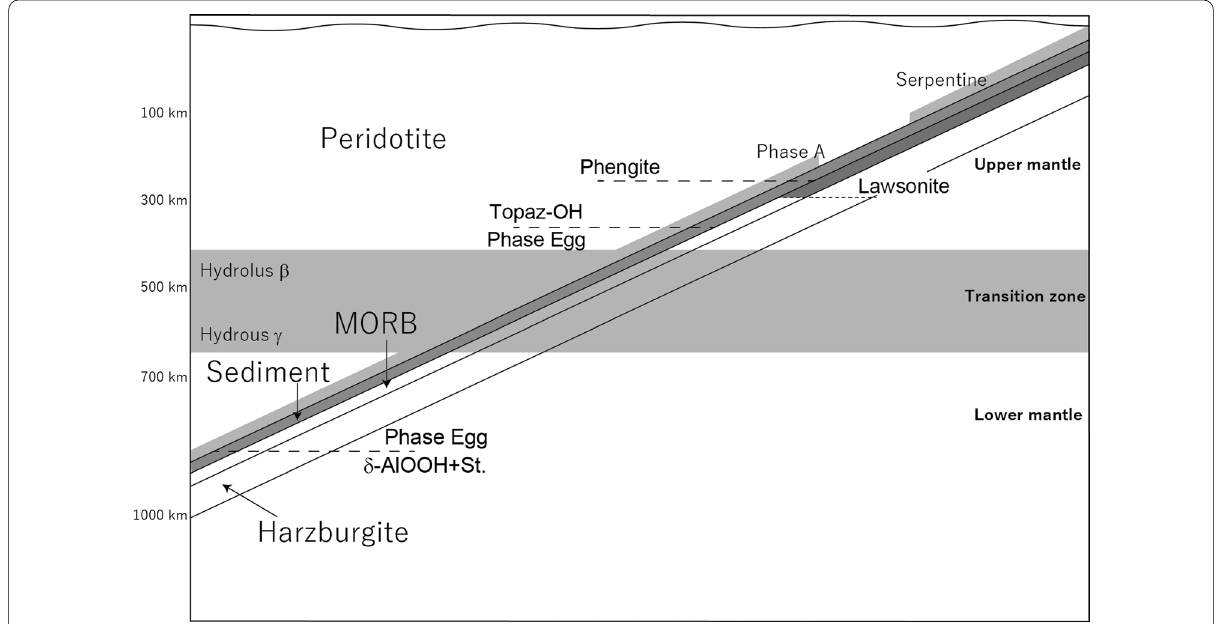
Fig. 2 Schematic illustration of water transport by the subducting slab. Gray areas represent wet regions (Modified from Ono